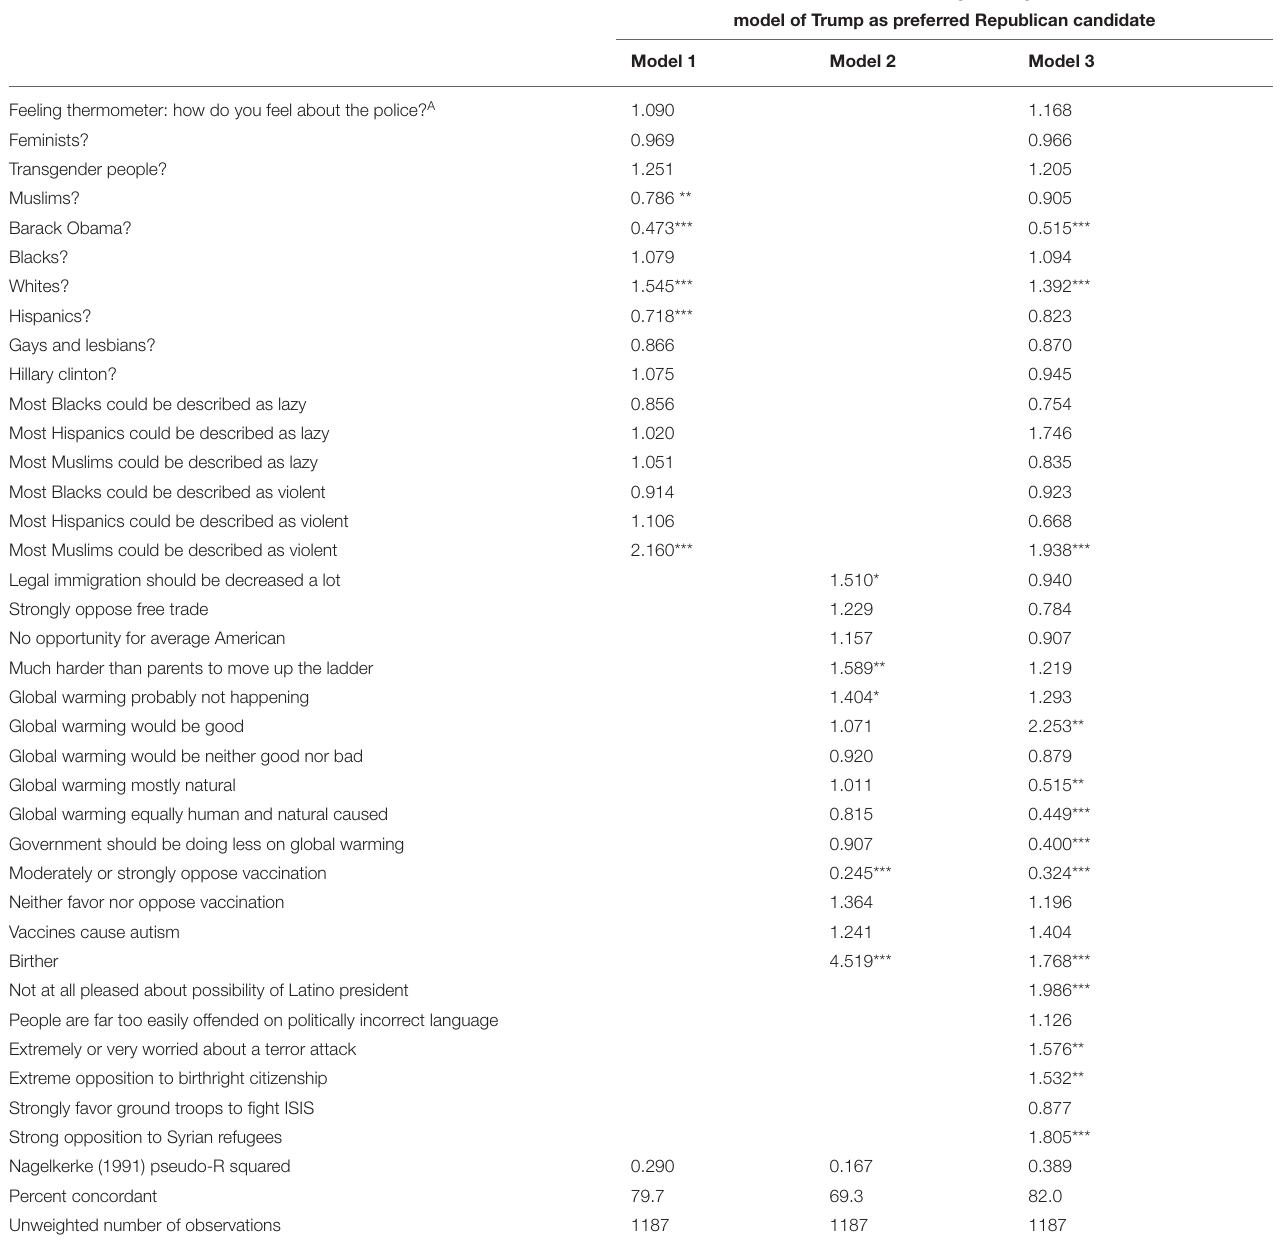
Odds ratios from logistic